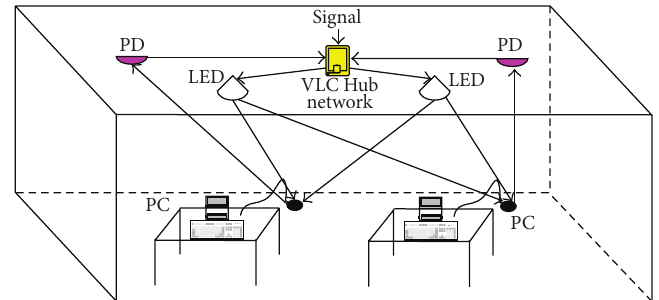
Figure 1: Indoor visible light communication system.